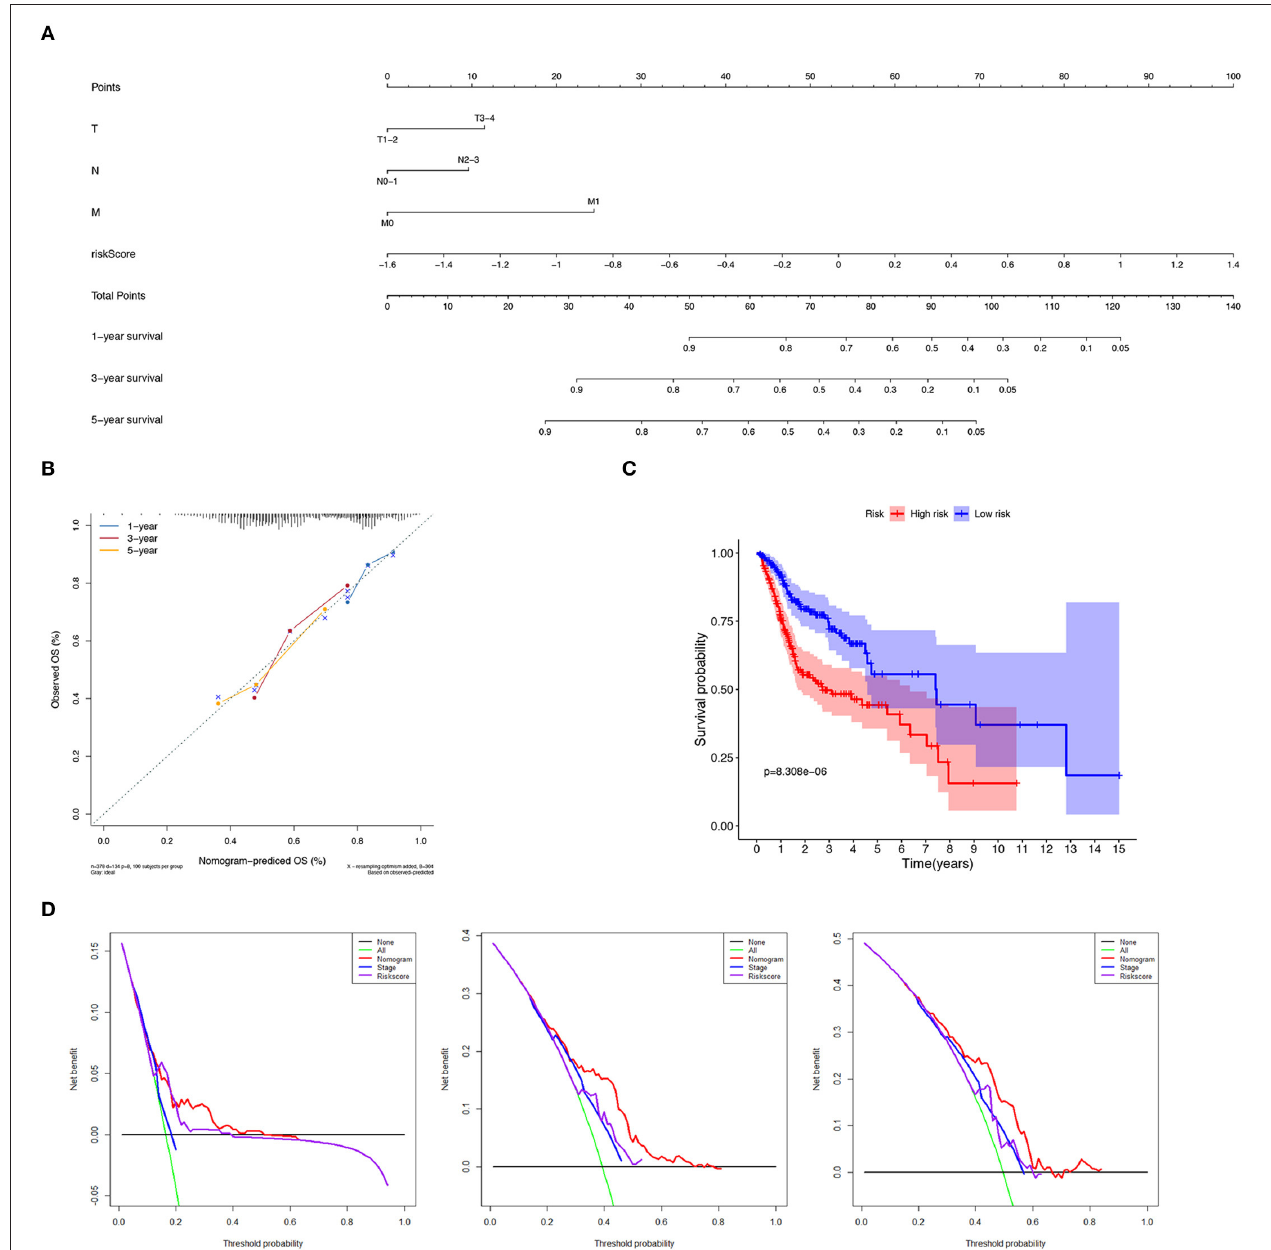
FIGURE 7 | Verification of nomogram prediction performance. ( A) A nomogram based on 7 genes and related clinical parameters. ( B) The calibration curve reflects the accuracy of the nomogram to estimate the risk. (C) The Kaplan–Meier analysis of the nomogram. (D) The DCA curves evaluate the clinical benefit and the application range of the